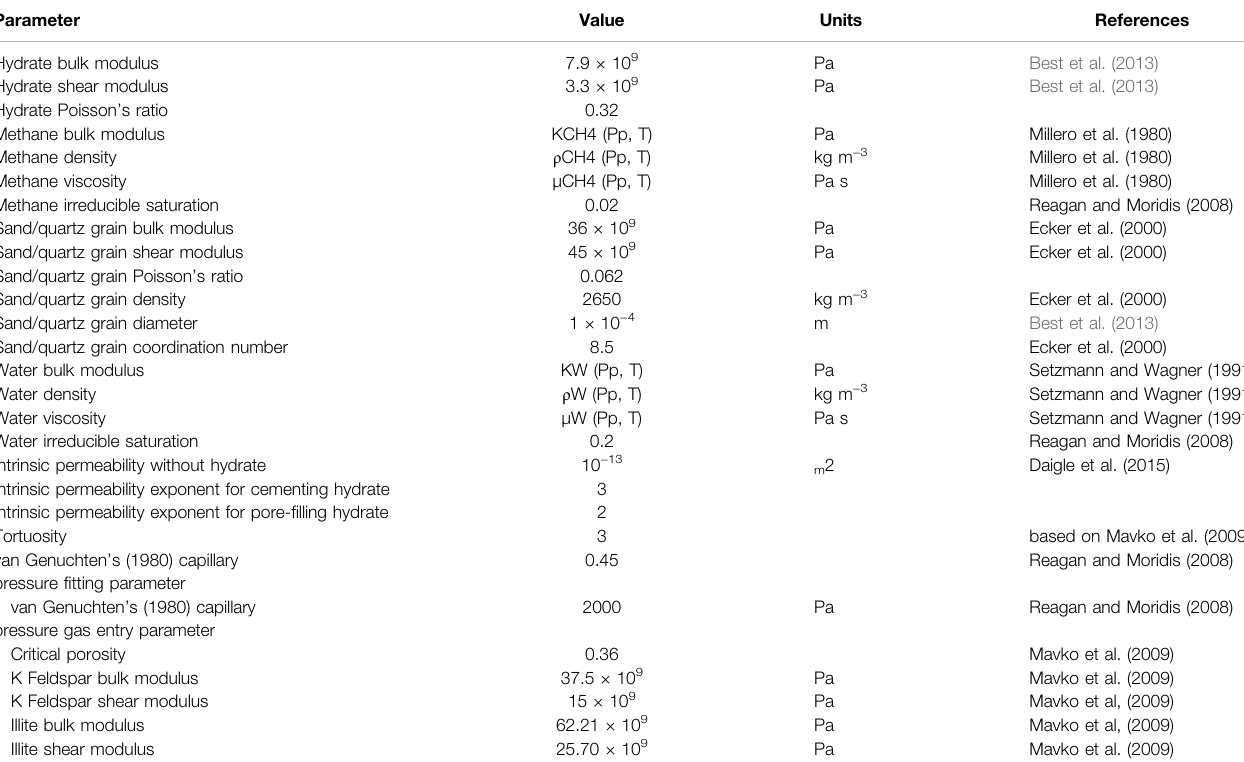
TABLE 3 | Values used in the HBES model runs (Marín-Moreno et al., 2017).